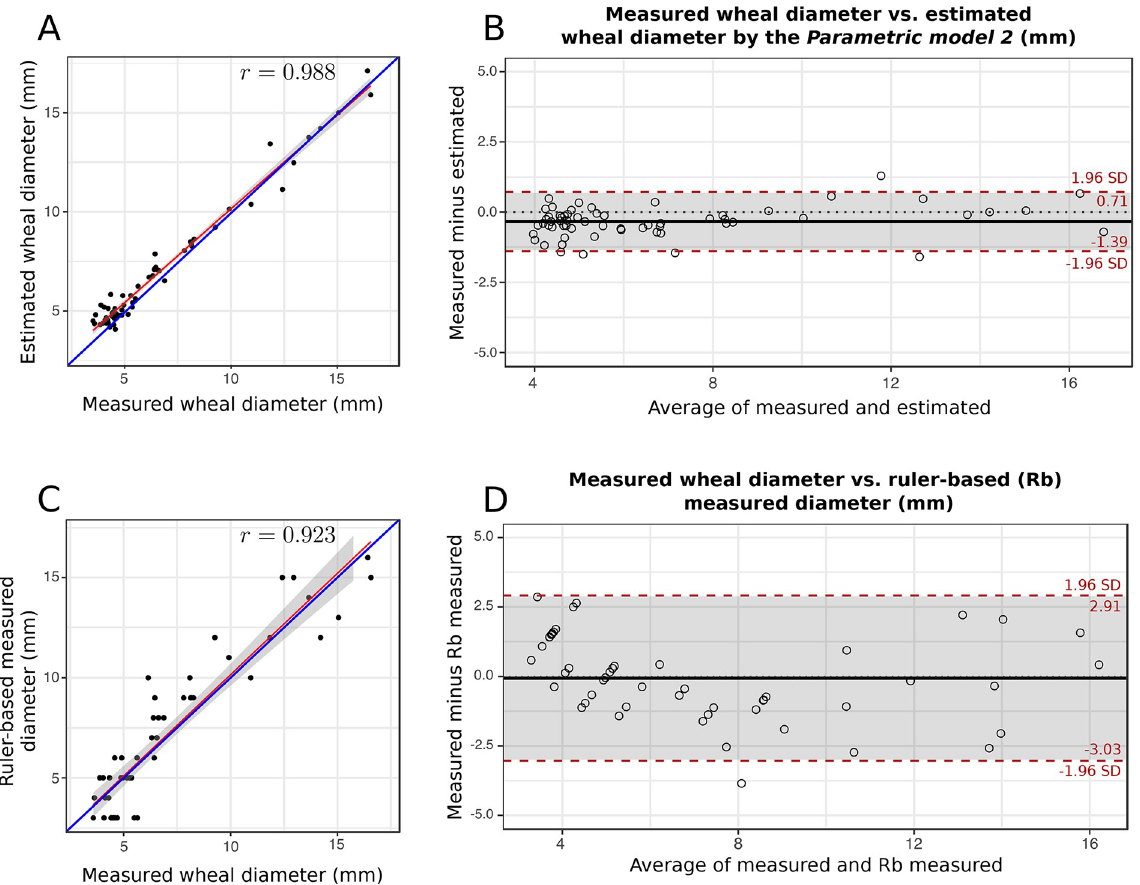
Fig 9. (A) Scatter plot, and (B) Bland-Altman plot of measured wheal diameter vs. estimated wheal diameter by the parametric model 2. The 95% agreement limits are [ − 1.58, 0.78] mm, which are close to the desired ± 1 mm. (C) Scatter plot, and (D) Bland-Altman plot of measured wheal diameter vs. ruler-based measured diameter. Although, the mean difference is close to zero the 95% agreement limits are [ − 3.03, 2.91] mm, which are three times larger than the desired ± 1